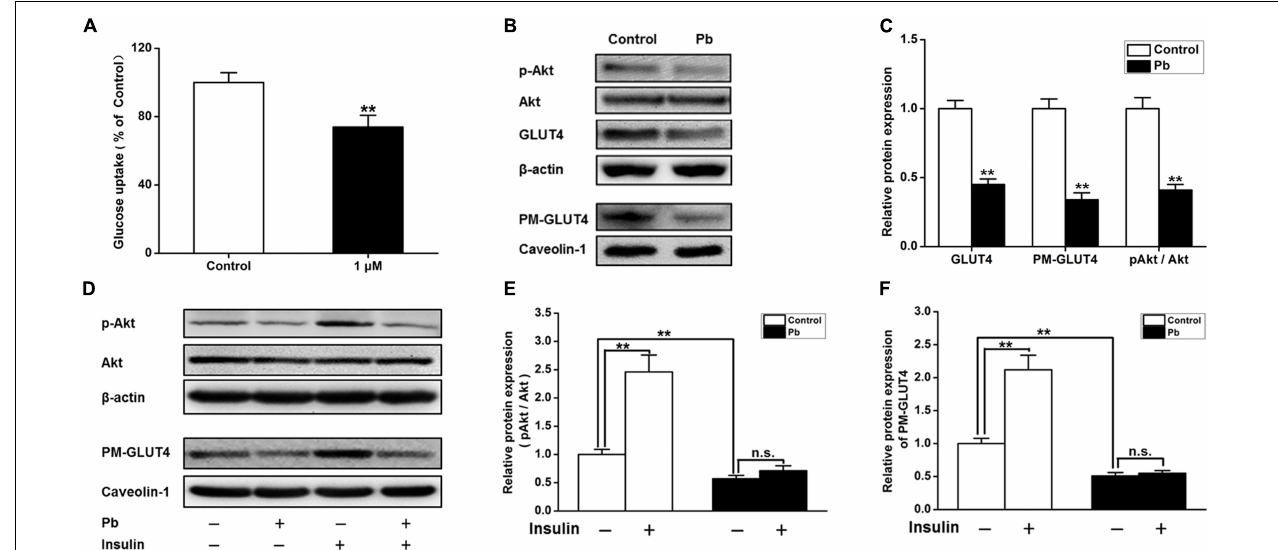
FIGURE 5 | Effects on the glucose uptake and GLUT4, PM-GLUT4, and p-Akt expression in primary hippocampal neurons in the Pb-exposed rats. (A) Effect of Pb exposure on the glucose uptake. Using 2-NBDG combined with flow cytometry, glucose uptake in primary cultured rat hippocampal neurons was analyzed. Flow cytometry results showed that glucose uptake was significantly reduced in primary cultured hippocampal neurons after treatment with 1 µ mol/L Pb acetate compared with the levels in the control group. (B,C) Effect of Pb exposure on expression of glycometabolism-related proteins in the brain. The expression levels of GLUT4, PM-GLUT4, and pAkt proteins in primary cultured hippocampal neurons were dramatically reduced in the Pb-exposed rats. (D–F) p-Akt and PM-GLUT4 expression after insulin stimulation in rat primary cultured hippocampal neurons. Insulin stimulation led to the significant increase of p-Akt and PM-GLUT4 protein levels in the control rat hippocampus, but did not reverse the decreased levels in Pb-exposed rats. Among them, caveolin-1 served as the loading control of PM-GLUT4, and β -actin for other proteins. ** p < 0.01, n = 6 per group. Statistical analysis of the band intensity measured as a percentage of the